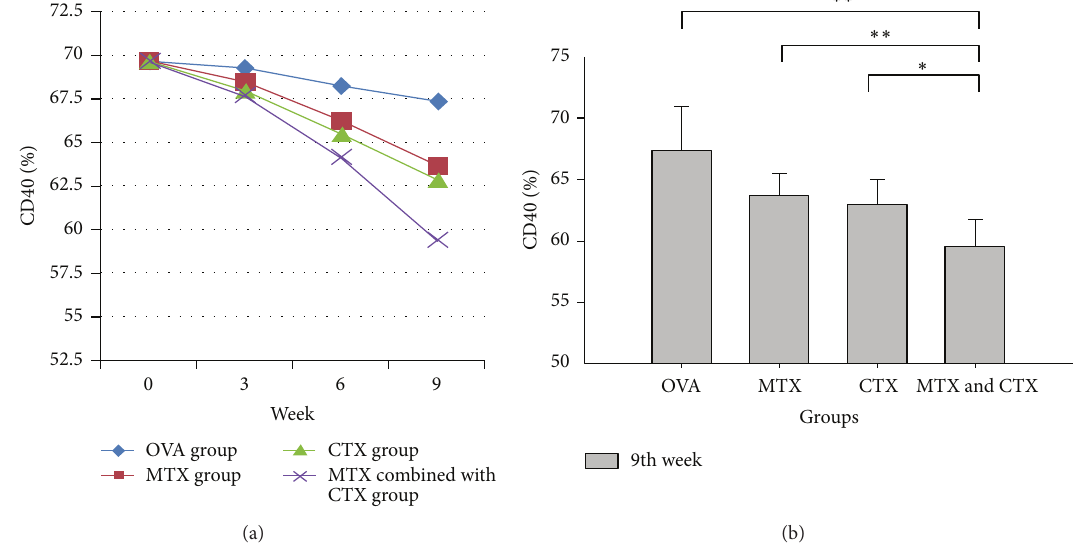
Figure 1: (a) Dynamic changes of CD40 expression in each group. (b) Comparison of CD40 expression in each group on 9th week. Data represented one of at least three independent experiments with 5 mice per group ( ∗ 𝑃 < 0.05 , ∗∗ 𝑃 < 0.01 ).